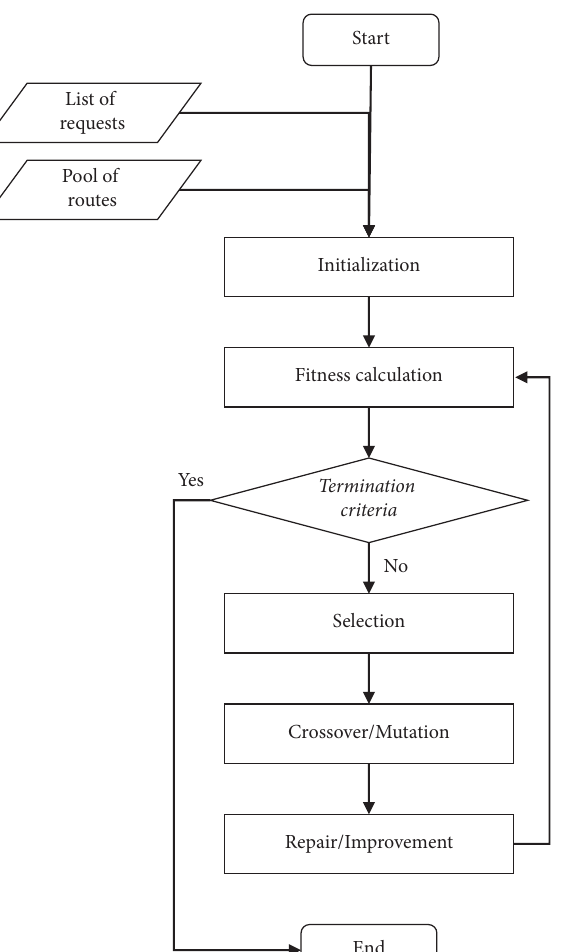
Figure 4: Flowchart of the memetic algorithm.